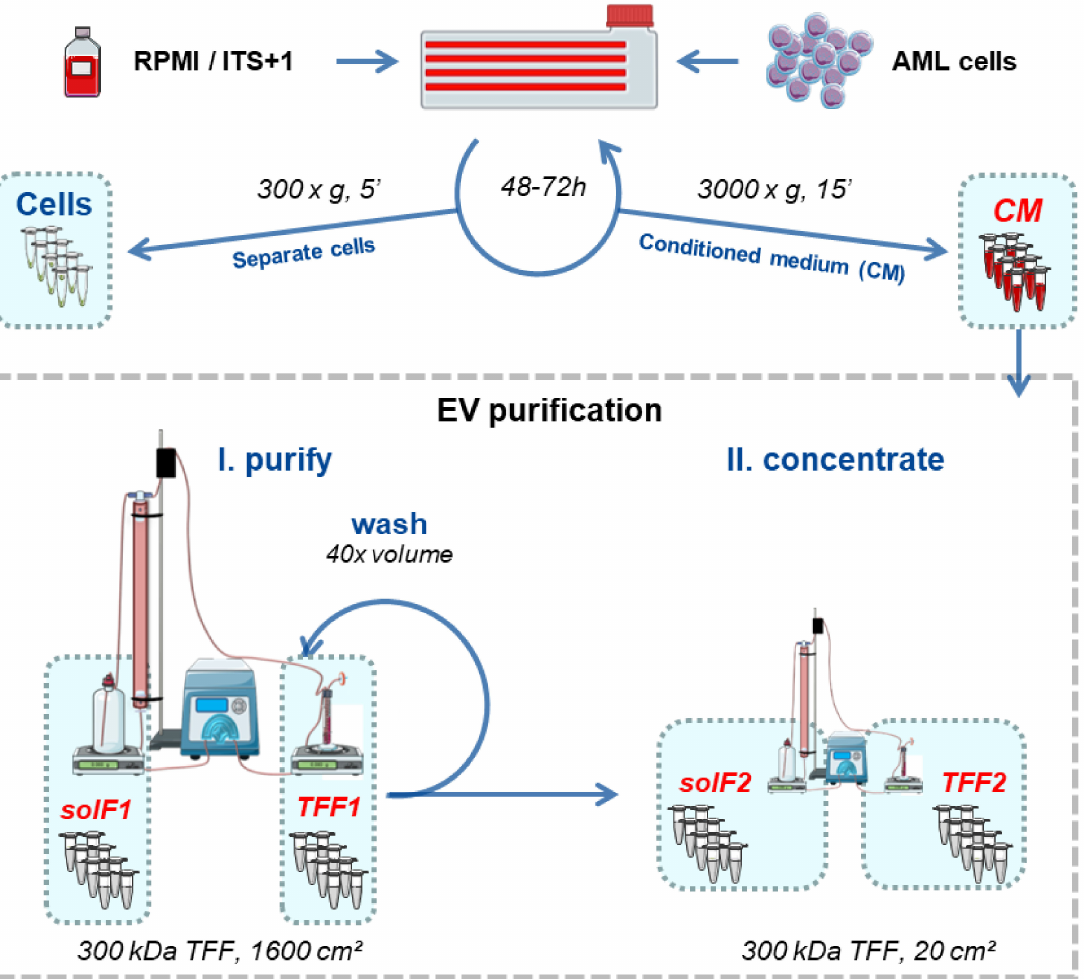
Figure 1. Schematic workflow for serum-free large-scale EV production from AML cell lines. Cells were cultured for 48–72 h intervals in RPMI/ITS+1. AML cells (viability ≥ 85%) were separated by centrifugation (300 × g , 5 min, RT), and the